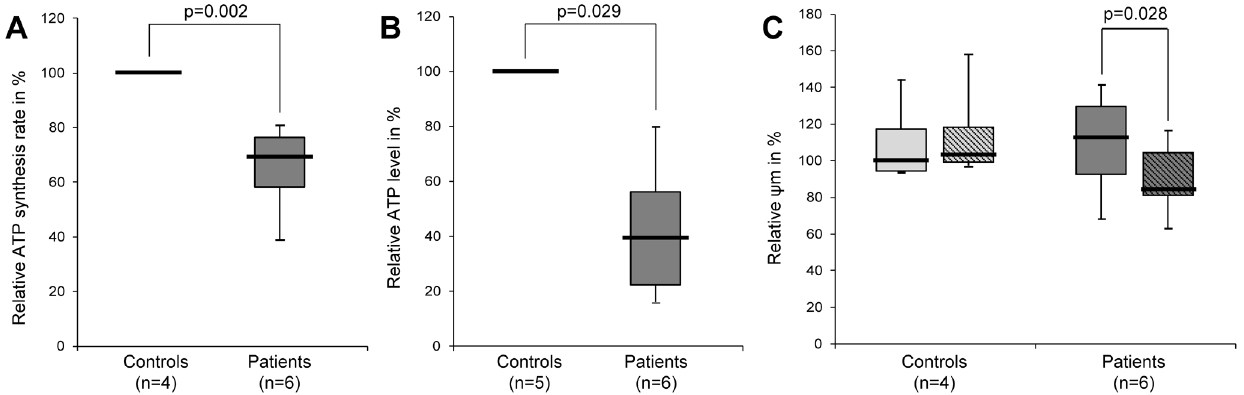
Figure 1. Mitochondrial function. (A) Basal ATP synthesis rates. The assay demonstrated a significant reduction in ATP production in the Parkin - mutant patients (median [IQR]: 39% [23%, 55%]) compared to controls (set to 100%). (B) Basal ATP levels. Quantifying the overall cellular ATP concentration showed significantly lower levels in the mutants (median [IQR]: 69% [58%, 75%]) than in controls (set to 100%). (C) Mitochondrial membrane potential under basal and oxidative stress conditions. Control (median [IQR]: 100% [94%, 115%]) and patient fibroblasts (median [IQR]: 113% [93%, 128%]) with Parkin mutations show similar membrane potential under basal conditions. When the cells were treated with paraquat (shaded boxes), no relevant changes were detected in the controls (median [IQR]: 102% [100%, 118%]). In the Parkin mutants, a significant drop of the membrane potential was observed (median [IQR]: 84% [81%, 103%]). The median, the interquartile range (IQR), the minimum and the maximum value of 6 (A) or 4 (B) independent experimental runs are plotted. In each experimental run the average ATP level in the controls was set to 100%.